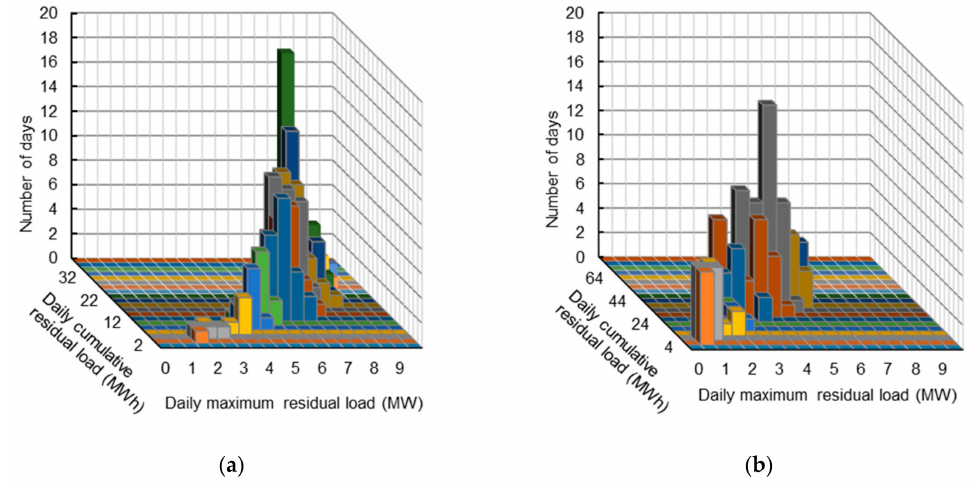
Figure 4. Comparison of daily cumulative and maximum residual loads: ( a ) From 3 to 7 p.m. and ( b ) From 7 p.m. to 8 a.m. (following